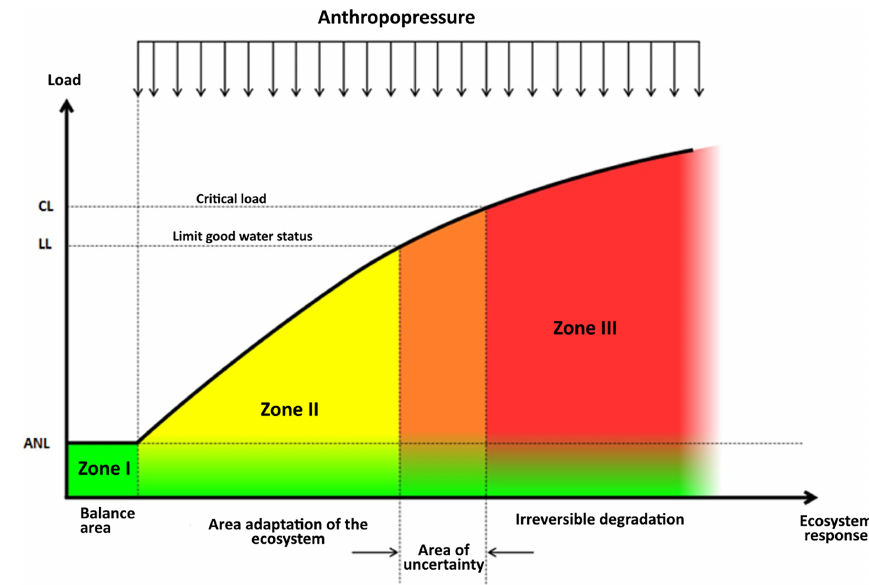
Figure 1. The impact of anthropopressure on the ecosystem surface water at the